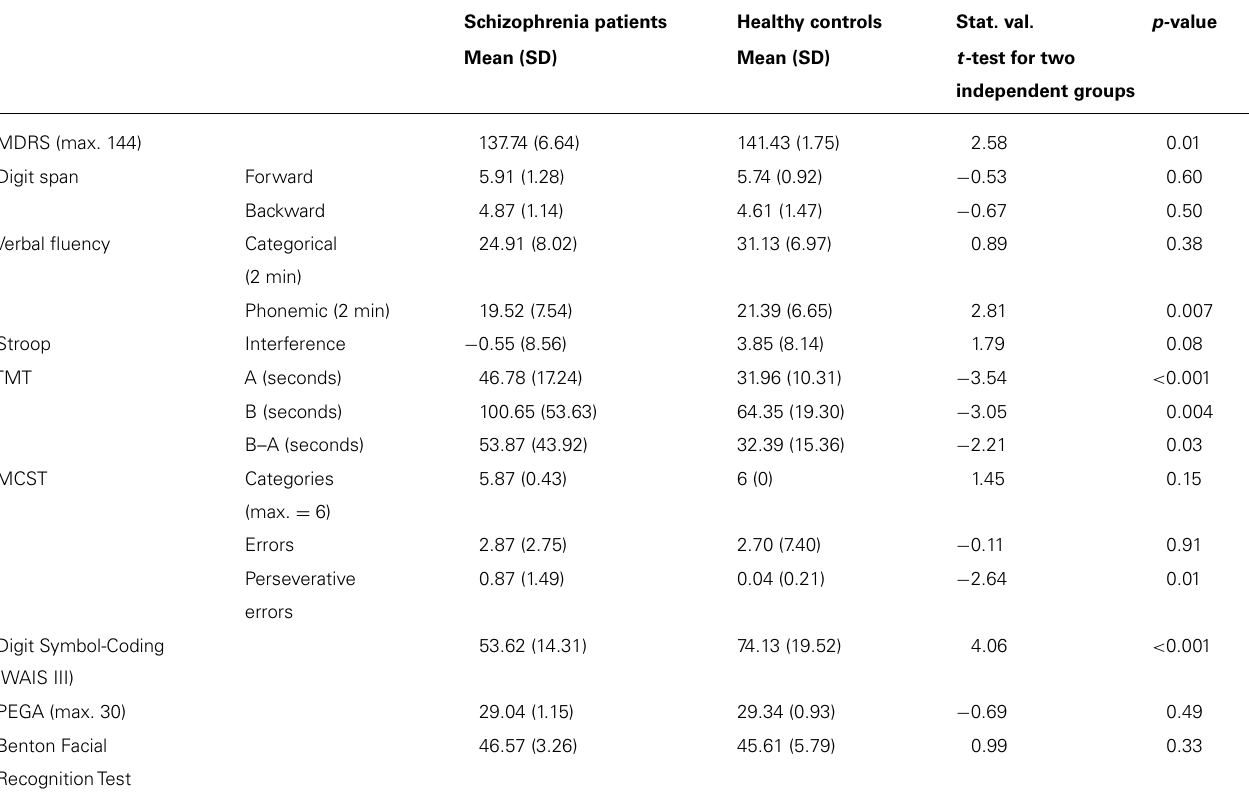
Table 2 | Neuropsychological background of patients with schizophrenia and healthy control